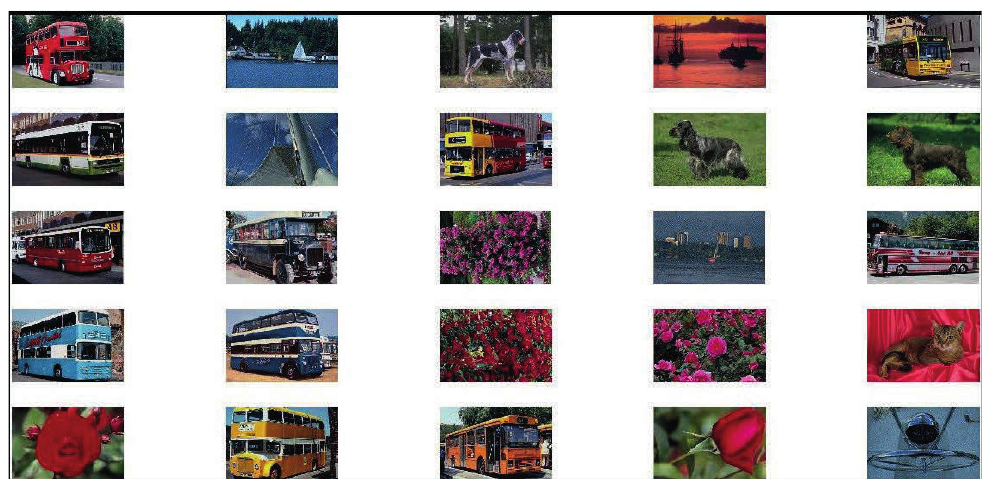
Fig. 24. Bus images retrieved at the first stage of Framework-2